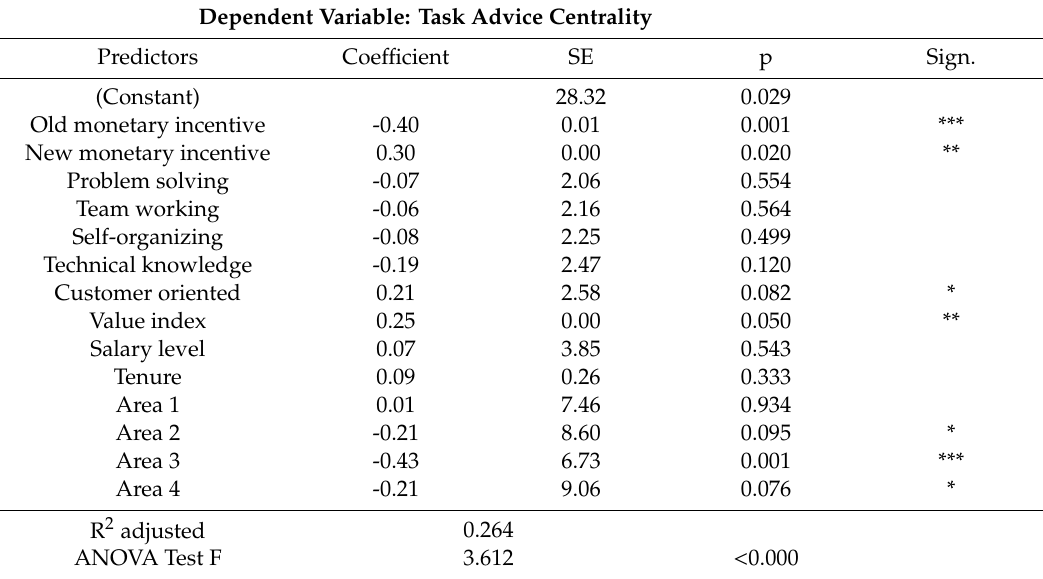
Table 6. Second detection (year 2013).